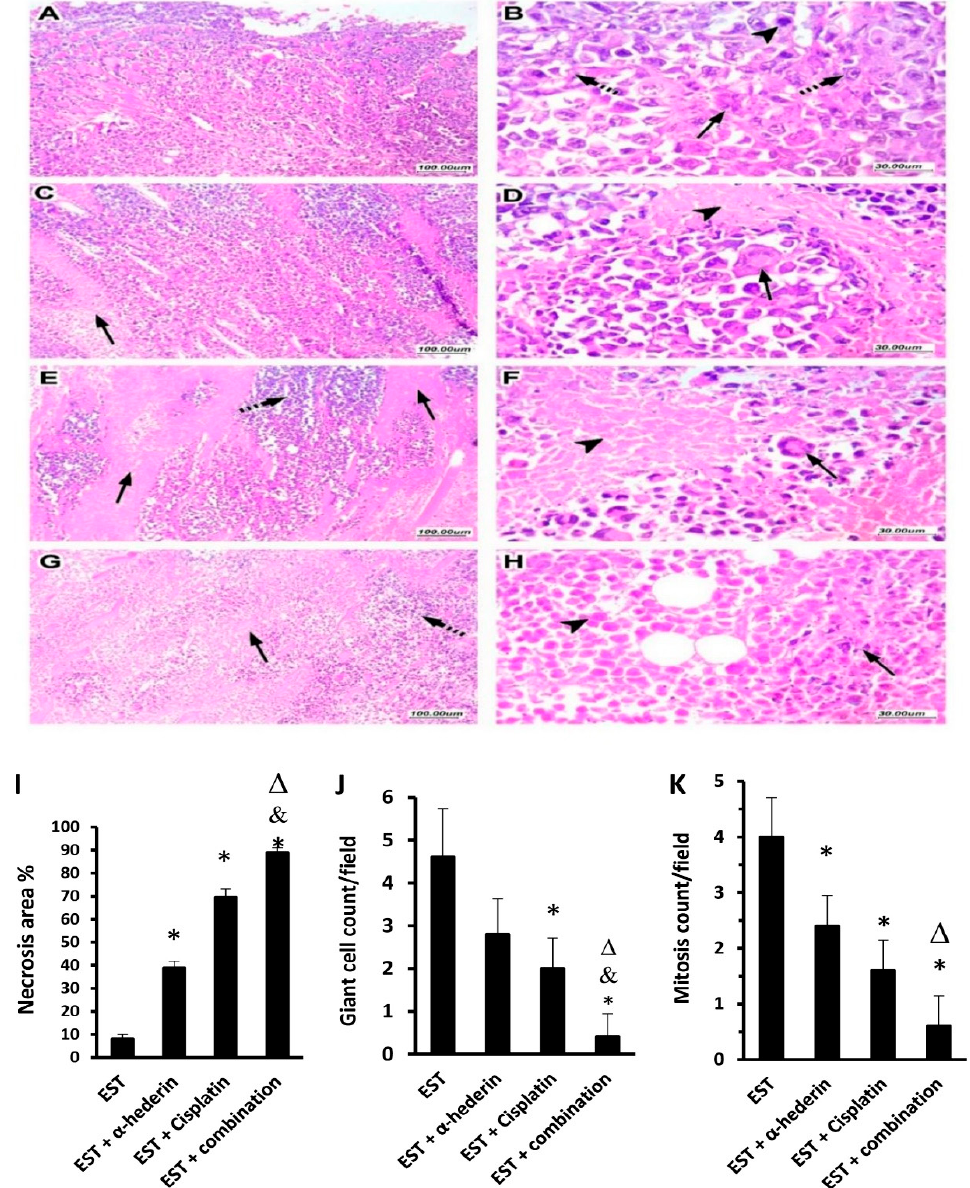
Figure 5. Hematoxylin and eosin staining for solid tumors from the tumor control group and cisplatin groups. Panel ( A , B ) show low- and high-magnification images of the control group with viable tumor cells with infiltration of surrounding tissues. Panel ( C , D ) show low- and high-magnification images of cisplatin group tumor showing tumor necrosis appearing as granular eosinophilic structureless areas (arrow, panel ( C )), with central viable tumor cells (arrow, panel ( D )). Panel ( E , F ) low- and high-magnification images of EST + α -hederin group showing areas tumor necrosis (arrow, panel ( E )), with residual viable tumor cells (dashed arrow, panel ( F )), with scattered giant cells (arrow, panel ( F )) and necrotic cells (arrowhead, panel ( F )). Panel ( G , H ) low- and high-magnification images of EST + combination group showing wide areas of necrosis (arrow, panel ( G )) and scattered very few viable cells (arrow, panel ( H )). Comparison of the pathological findings in solid tumor sections are shown in ( I ) necrosis area %, ( J ) giant cell count, and ( K ) mitosis count. The pathological findings were determined for six random fields/tumor section and averaged. EST: Ehrlich solid tumors, Data are mean ± SD, *: versus EST control group, &: versus EST + α -hederin group, ∆ : versus EST + cisplatin group at p < 0.05. Data are mean ± SD and were compared at p < 0.05.